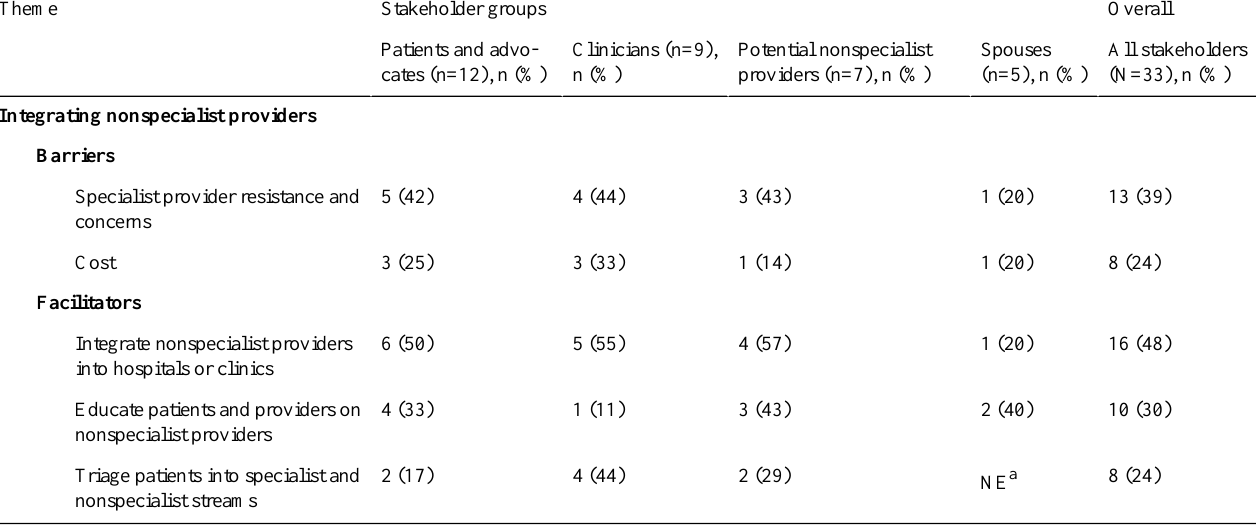
OverallStakeholder groupsTheme